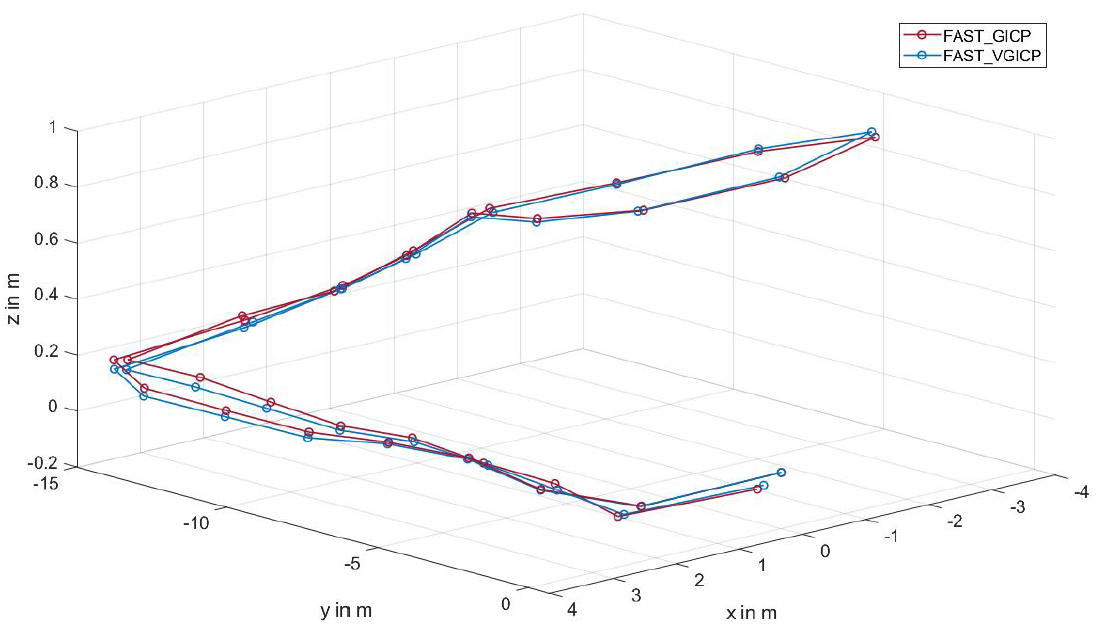
Figure 20. Height course of the trajectory determined by hdl_graph_slam with deactivated floor_detection node.